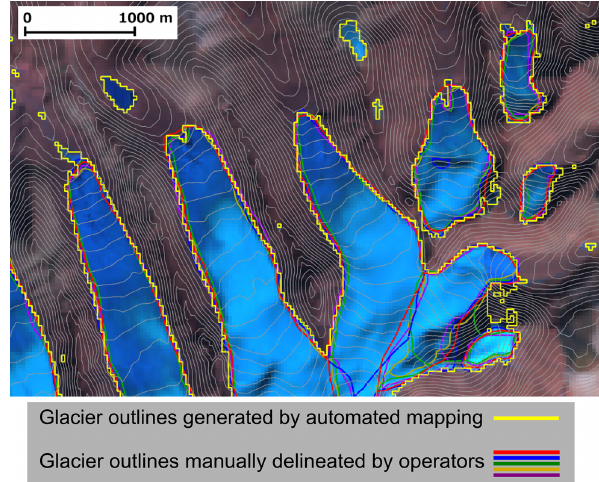
Figure 2. Comparison of debris-free glacier delineation at 28.380 ◦ N, 86.472 ◦ E, using automated mapping derived from the band ratio method (grid cells with band3/band5 > 1.8 are glacier ice; Paul et al., 2013) and manual delineation. Background imagery is Landsat false-colour (bands 7, 4, and 2 as RGB) composite im- agery, taken on 5 January 2002, at path 145 row